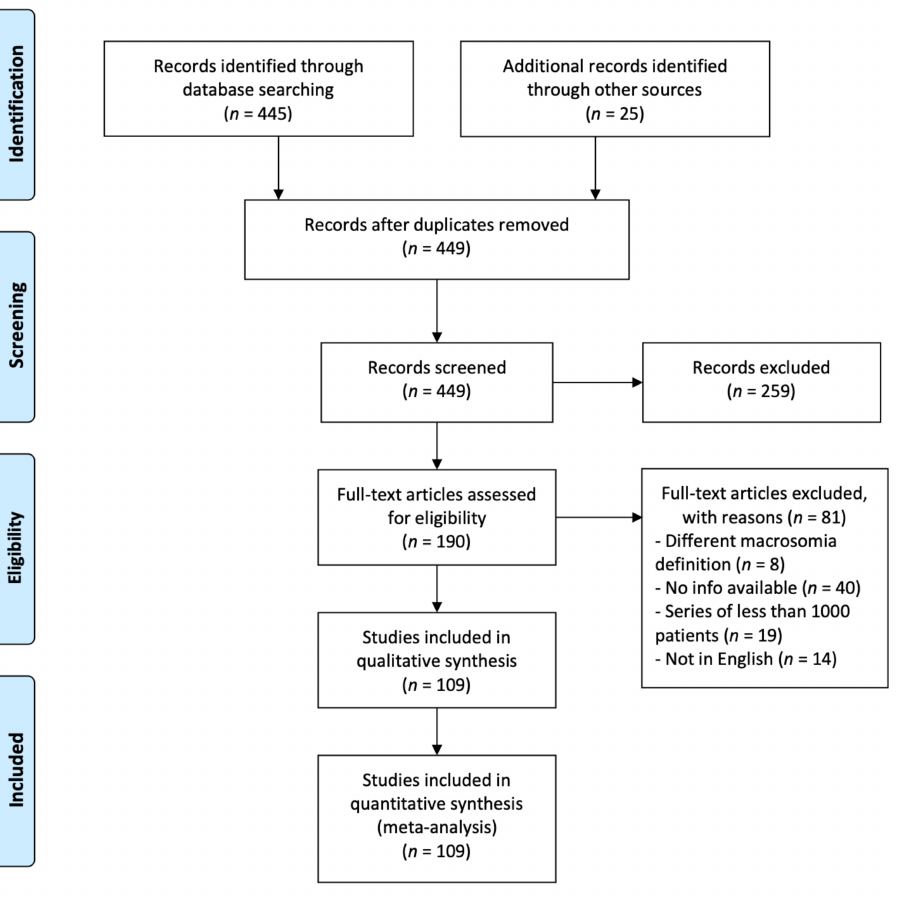
Figure 2. PRISMA flow diagram summarizing the literature search and article screening